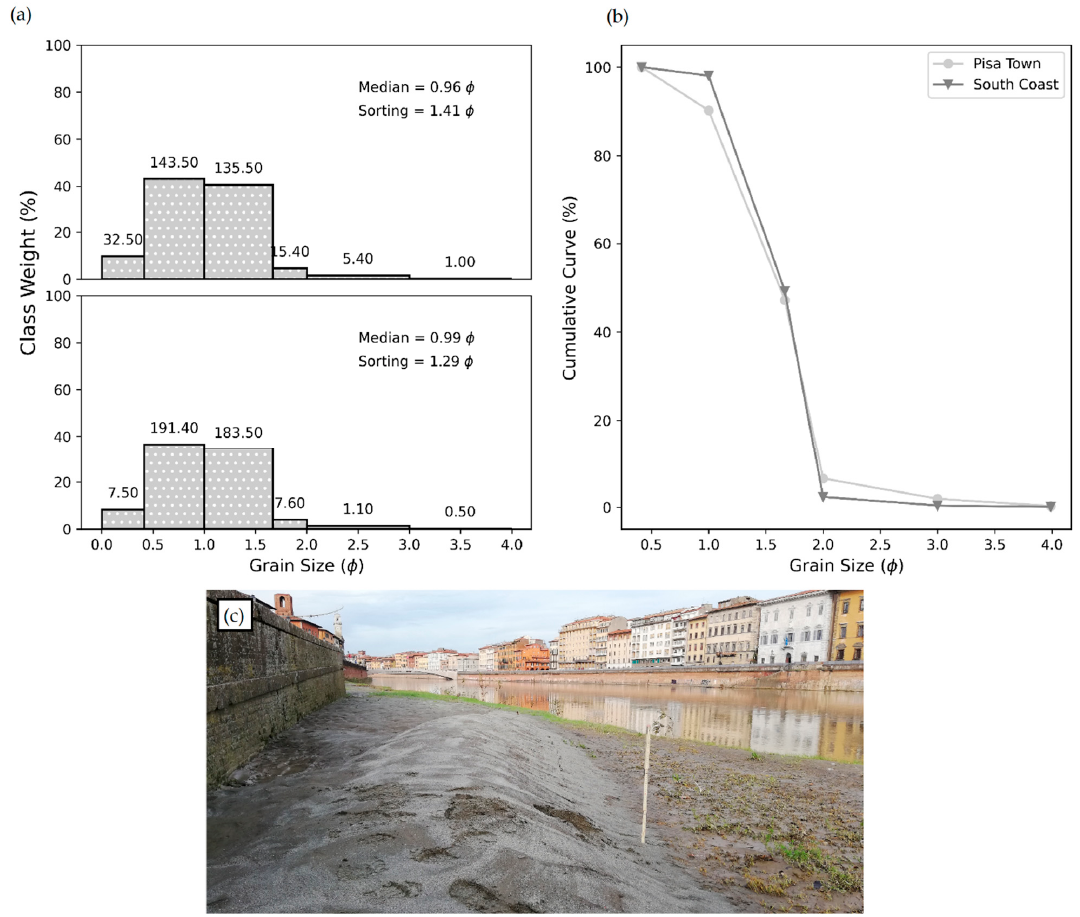
Figure 10. Grain size analysis of sediment samples in the city of Pisa and along the South Coast. ( a ) Histogram of grain size ( φ ) of samples in Pisa (top) and along the South Coast (bottom); ( b ) cumulative curve of two samples; ( c ) photograph showing sampling site.